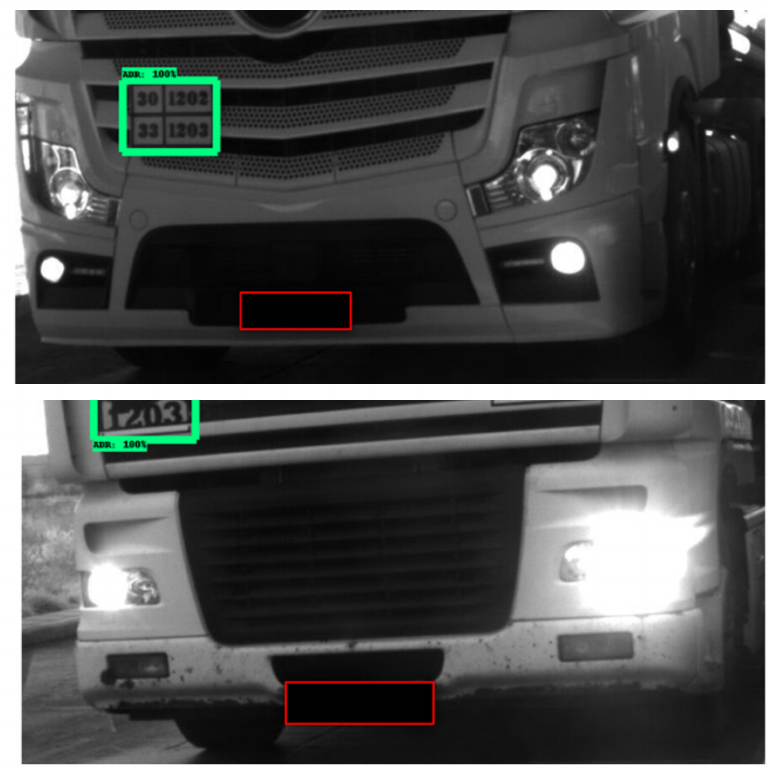
Figure 6. Examples of ADR-Det algorithm successful ADR sign detection (green image box), using an evaluation dataset of 500 ADR images.